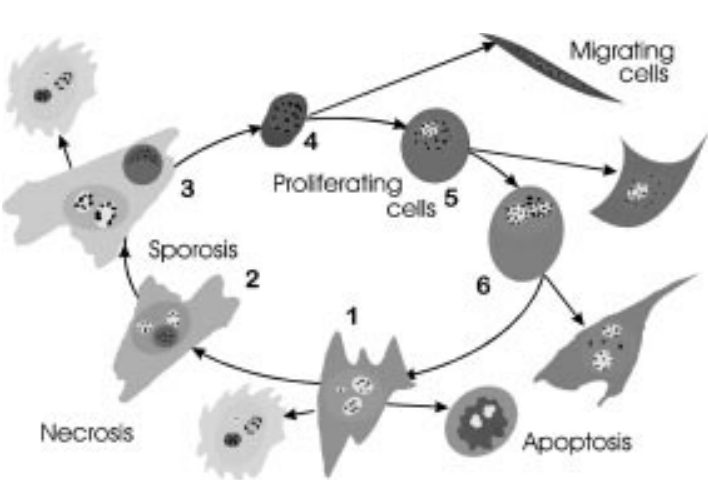
Fig. 11. A cytological mechanism of immortality of the human sarcoma cell line